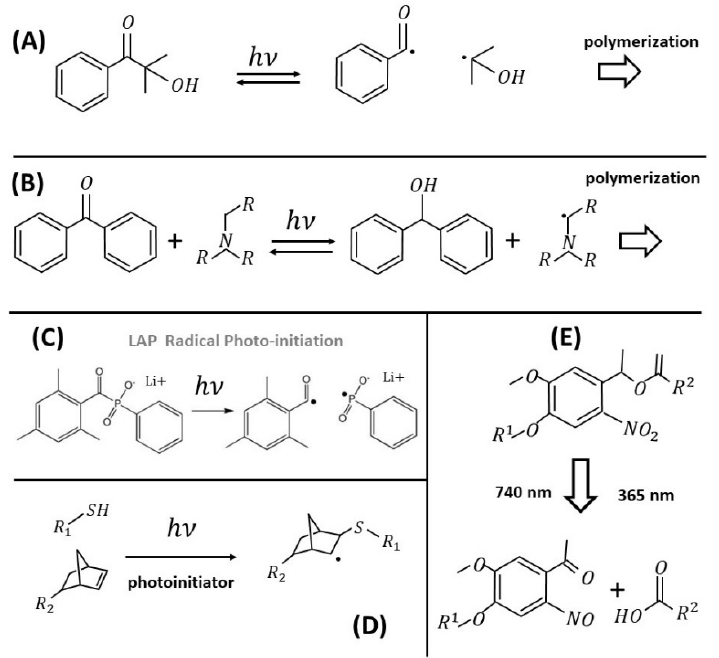
Figure 1. Norrish type of photoinitiation of the radical polymerization for type I photoinitiators ( A ) and type II photoinitiators ( B ). ( C ) represents schematically the photoinitiation of the PI LAP (see Table 1). ( D ) represents schematically the photoinitiation of one common photo-click reaction based on the norbornene moiety. ( E ) represents one common photo-cleavage reaction involving the NBE group (see Table 1). Table 2. Physical symbols describing the main features of pulsed lasers used for MPL fabrication. I Average intensity 𝑤 (cid:2868) Laser beam waist 𝑣 (cid:3046)(cid:3030)(cid:3028)(cid:3041) Scanning speed P Average power Two-photon cross-section Laser repetition rate Laser pulse width Rate of volume fabrication